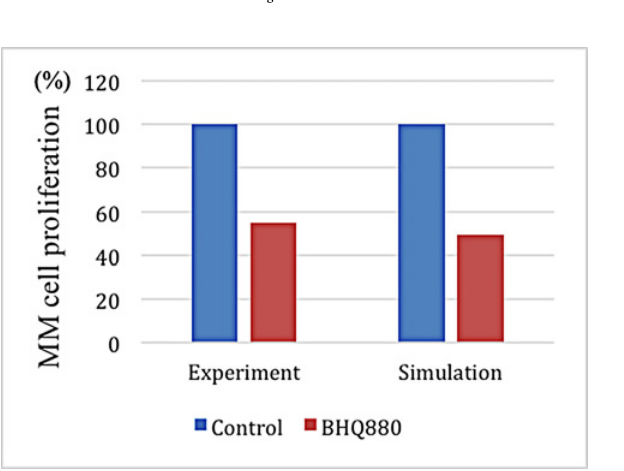
Fig 8. A comparison of the experimental and simulated data after BHQ880